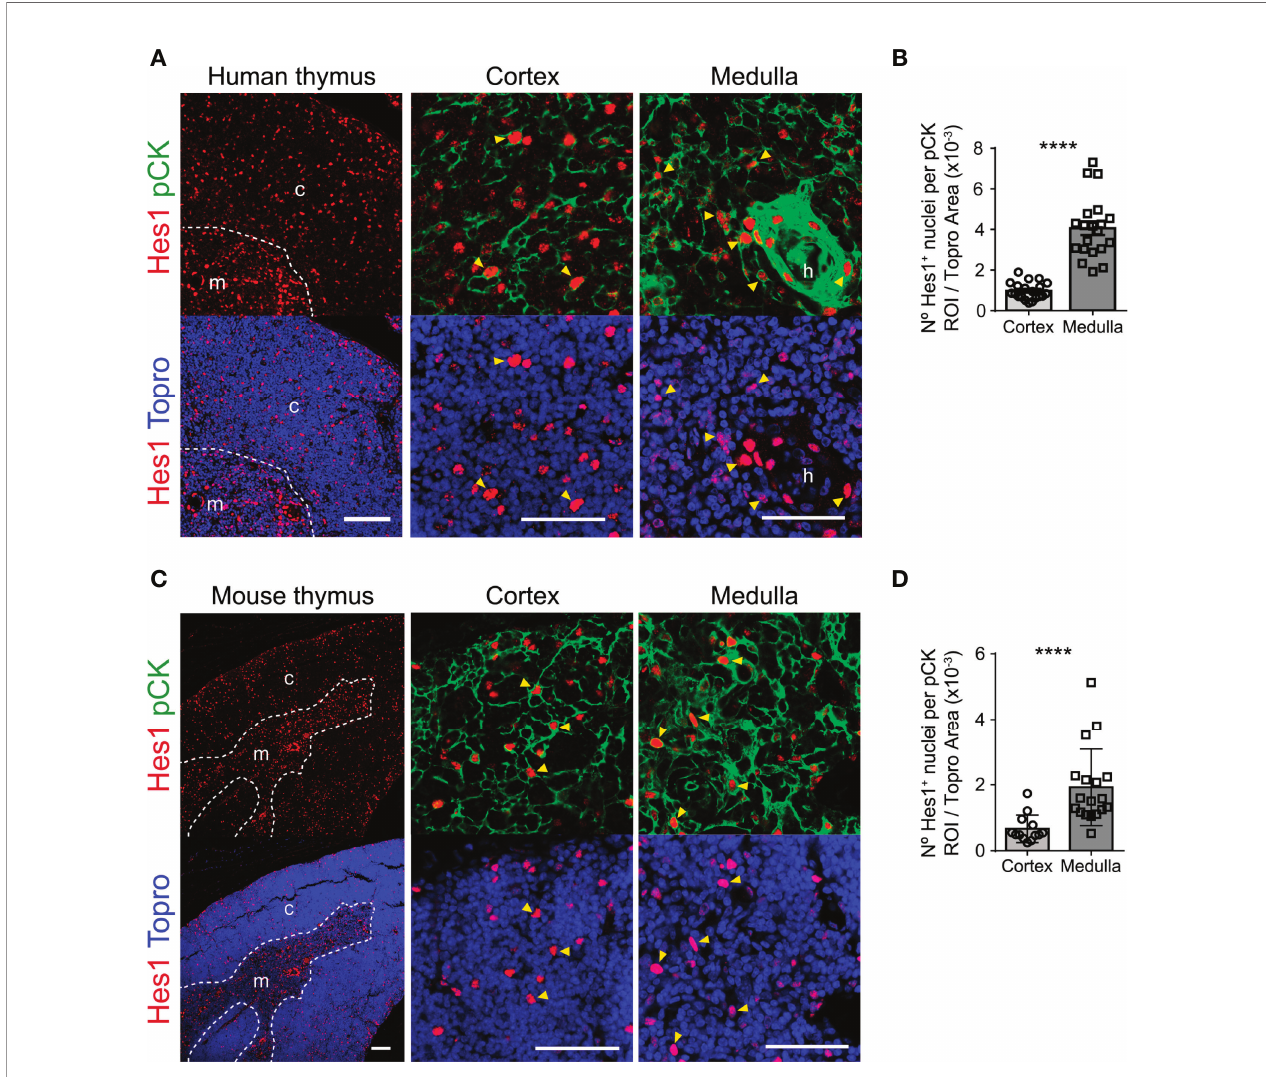
FIGURE 1 | Notch signaling is active in vivo in human and mouse postnatal TECs. Immunohistochemistry of the canonical Notch target Hes1 (red) in postnatal human ( ≤ 6-years) and mouse ( ≤ 5-months) thymus. TECs are characterized by expression of pCK (green). Topro3 shows nuclear staining (blue). (A) General view (scale bar: 100 m m) of Hes1 expression in a representative human thymus sample (18-months), and detailed view (scale bar: 50 m m) of Hes1 and pCK expression in the thymus cortex and medulla. Dotted line, corticomedullary junction; c, cortex; m, medulla. Arrowheads indicate Hes1 expression in TECs (pCK + ); h, Hassal ’ s corspuscles. (B) Bar graphs show numbers of Hes1 + nuclei within pCK + ROIs relative to total (Topro + ) cellular areas analyzed in the human thymus cortex and medulla. Data are shown as mean numbers ± SEM per fi eld obtained from n= 8-10 different 63x images from sample, (n ≥ 2 independent human thymus samples aged ≤ 6-years). ****p < 0.0001. (C) General view (scale bar: 100 m m) of Hes1 expression in a representative mouse thymus sample (5 months), and detailed view (scale bar: 50 m m) of Hes1 and pCK expression in the thymus cortex and medulla. Dotted line, corticomedullary junction; c, cortex; m, medulla. Arrowheads indicate Hes1 expression in TECs (pCK + ). (D) Bar graphs show numbers of Hes1 + nuclei within pCK + ROIs relative to total (Topro + ) cellular areas analyzed in the mouse thymus cortex and medulla. Data are shown as mean numbers ± SEM per fi eld obtained from n= 10 different 63x images from sample, (n ≥ 2 independent